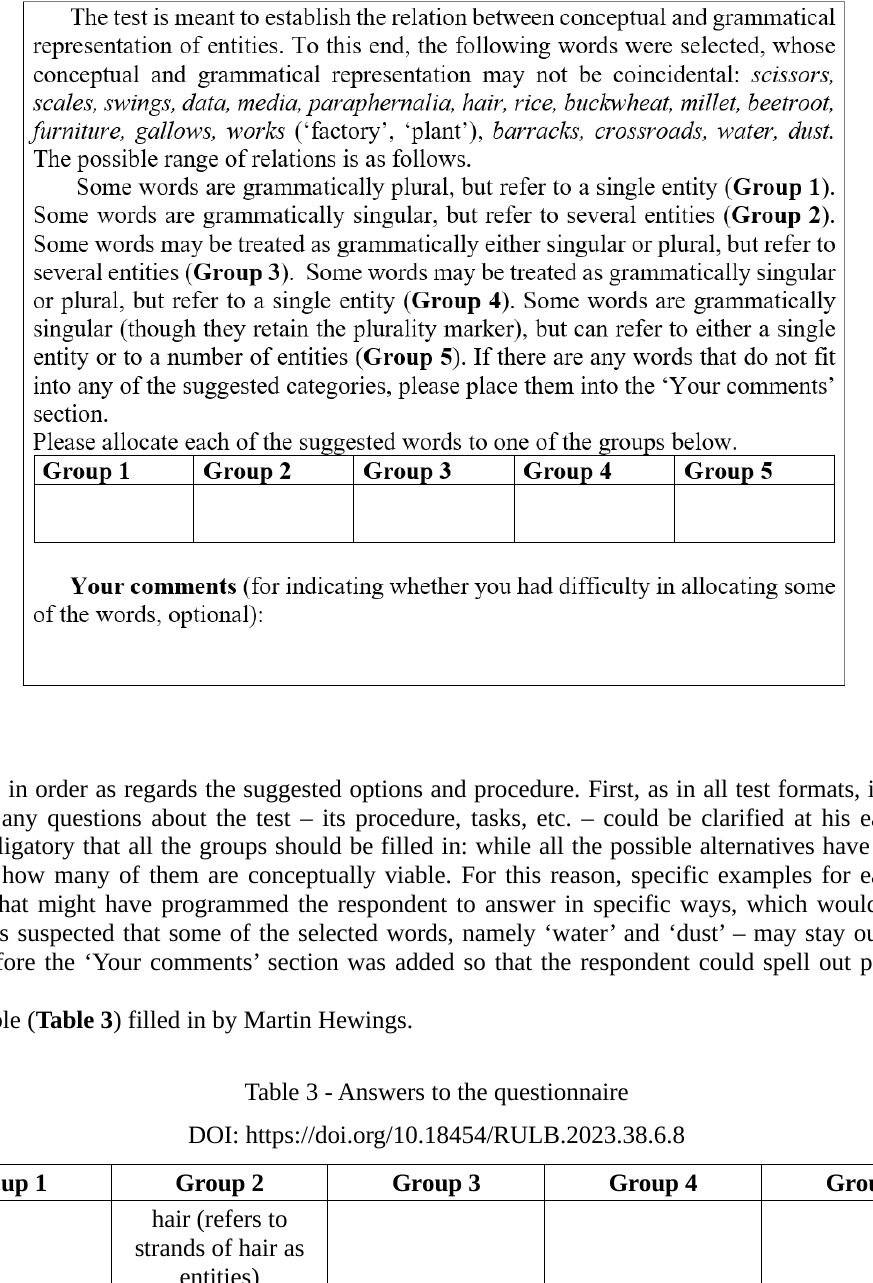
Table 2 - The questionnaire offered to a proficient native speaker in order to test the conceptual representation of entities that contain the idea of